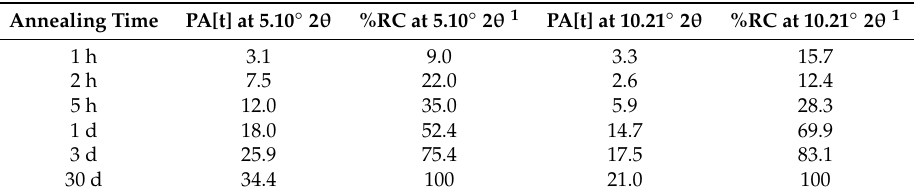
Table 3. Time-dependent change in the relative crystallinity (%RC) of the VRC-TAR cocrystal at an annealing temperature of 60 °C.